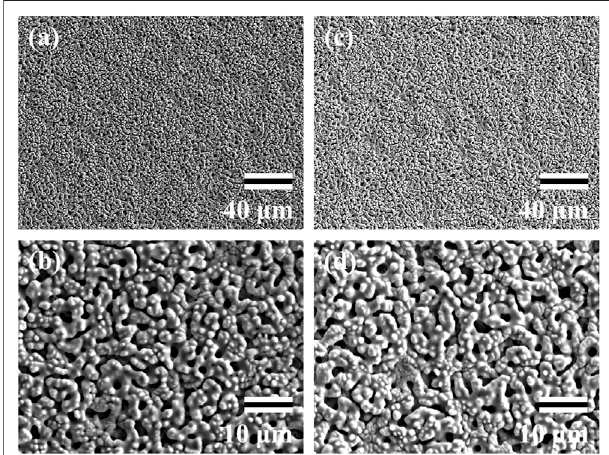
FIGURE 1 | SEM images of the anodic oxides prepared in a sodium tartrate electrolyte. a and b indicate anodic oxides with H 2 O 2 , c and d indicate anodic oxides without H 2 O 2 . Three independent experiments were conducted. Representative results are shown. Scale bar is 40.0 μ m in the lower magni fi cation images (A,C) and 10.0 μ m in the higher magni fi cation images (B,D) . SEM: Scanning electron